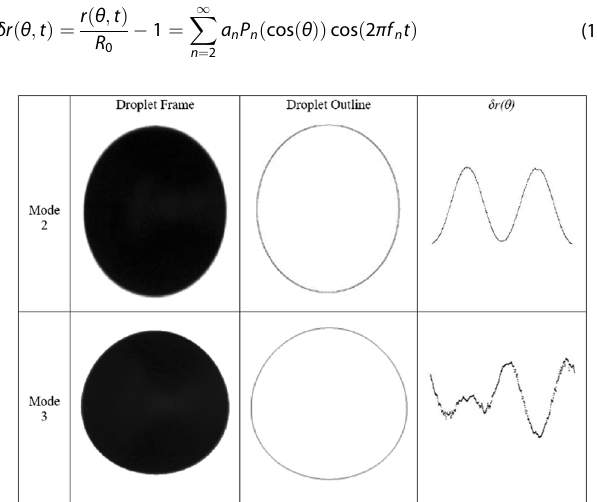
Fig. 9 A graphical illustration of the image analysis process for the projection method on mode 2 (top) and mode 3 (bottom). For each video frame, ImageJ software is used to convert the droplet ’ s shadow to an outline and subsequently convert the outline to polar coordinates. These polar coordinates are then projected onto the corresponding Legendre polynomial over the domain [0,2 π ] to fi nd the projection amplitudes, a n